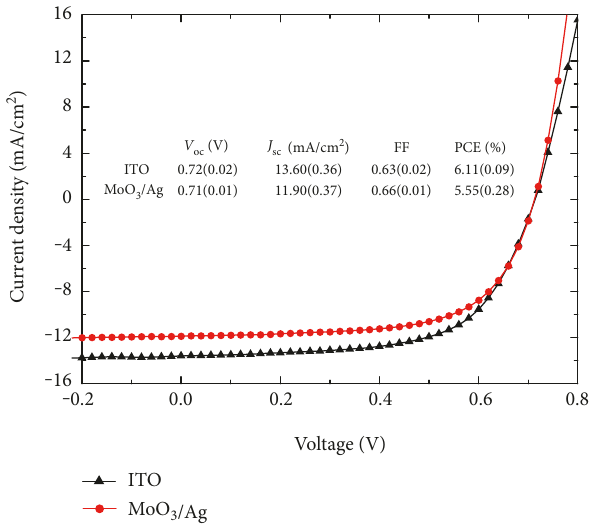
/Ag, 3 /Ag/ZnO samples, 3